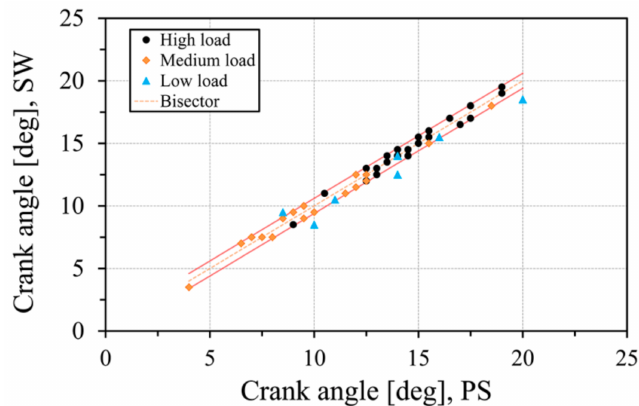
Figure 10. Angular position of the maximum in-cylinder pressure evaluated by the strain washer and the pressure sensor at different operating conditions in terms of load and regime (from 3000 to 6000 rpm) on the average-cycle.